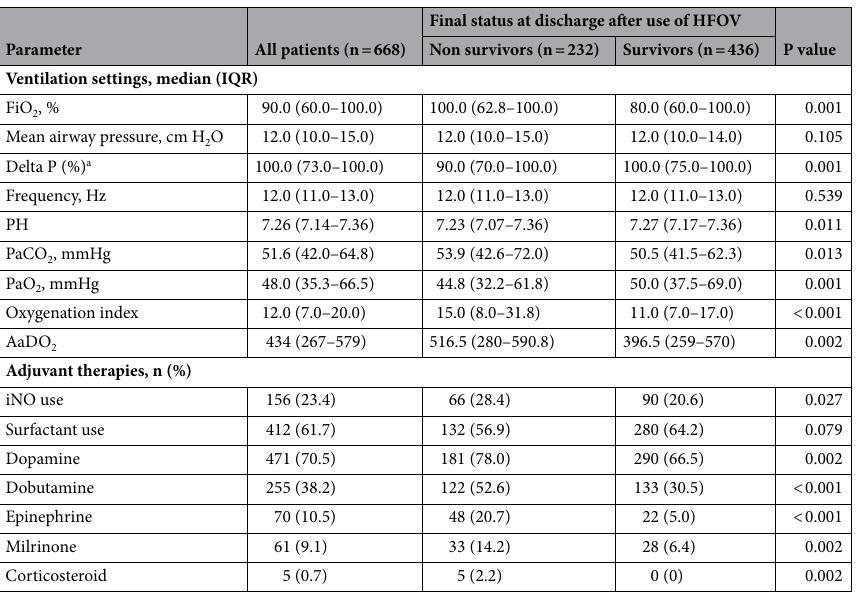
Table 2. HFOV management and HFOV-related complications during the first 2 days according to final survival status. Results are presented as n (%) or median (25th, 75th percentiles). a Delta P* are the expressed as the amplitude on the relative scale from 0 to 100% until the desired pressure or the desired tidal volume is achieved.